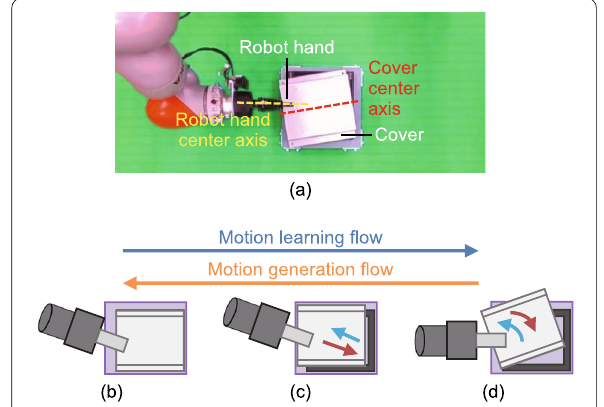
Fig. 5 Overview of motion teaching: position adjustment of cover and